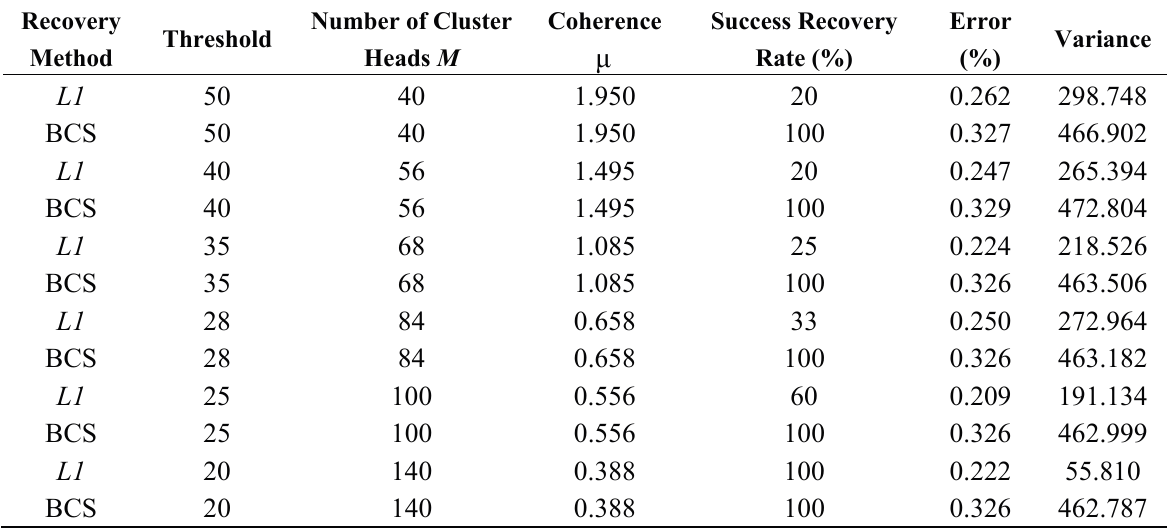
Table 1. Performance comparison for